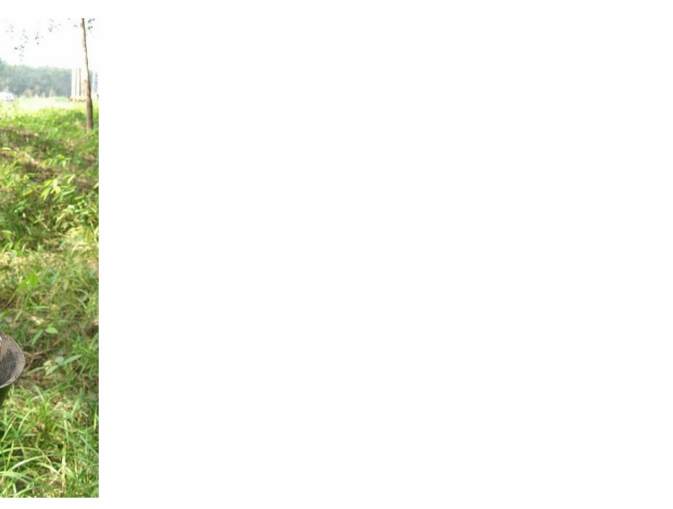
Figure 1. Latex being collected from a tapped rubber tree (PRA (2007) R é colte du latex sur un h é v é a au Cameroun. Freely redistribute under Creative Commons Attribution-Sharealike 3.0 Un- ported License. Figure available from https://commons.wikimedia.org/wiki/File:Latex_-_Hevea_-_ Cameroun.JPG